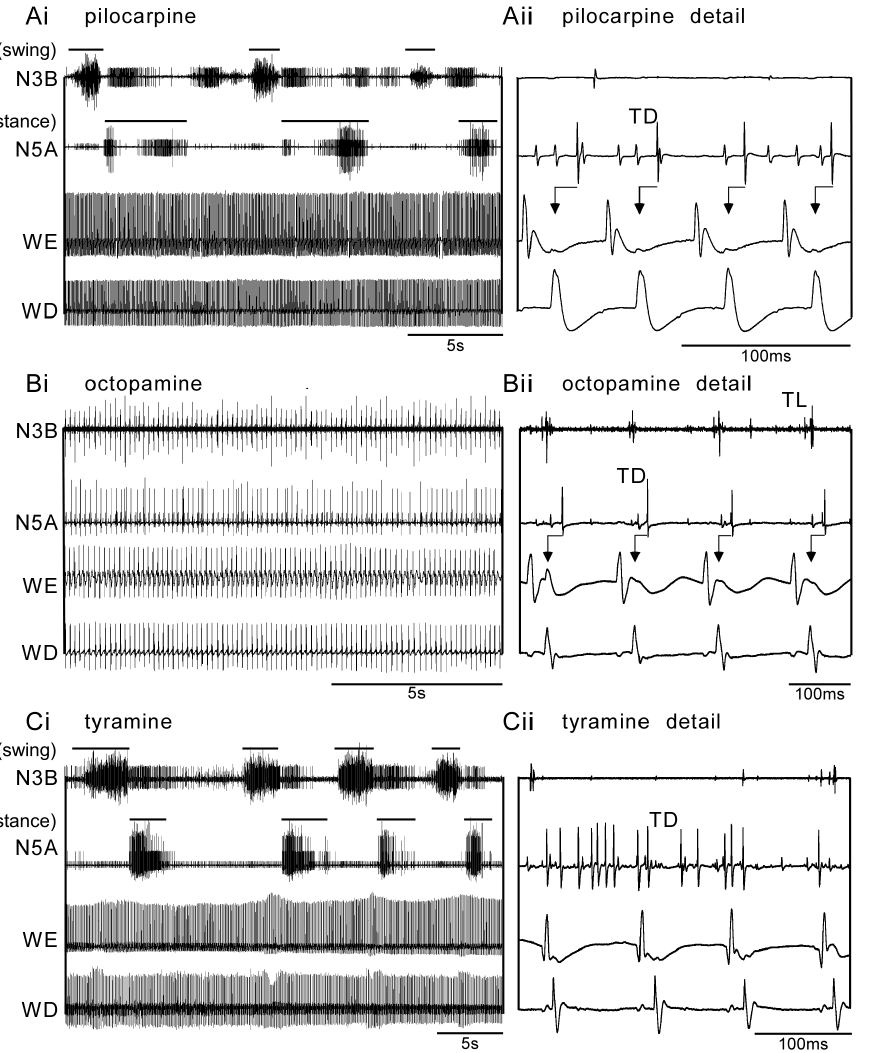
Figure 3. Exemplary simultaneous recordings showing motor activity in leg (upper two traces) and wing motor units (lower two traces) evoked by drug application in deafferented locust preparations: A pilocarpine (1 mM), B octopamine (100 mM), C tyramine (100 mM); i, ii each show a longer sequence and detail respectively. Abbreviations as in Fig. 1. Note that at the given concentrations pilocarpine and tyramine usually both evoke fictive walking together with flight, while octopamine evokes fictive flight in wing and leg motor units. The swing and stance phases of fictive walking are indicated by bars in Ai and Ci . Note coupling of leg unit TD to the WD (arrows in Aii , Bii ).